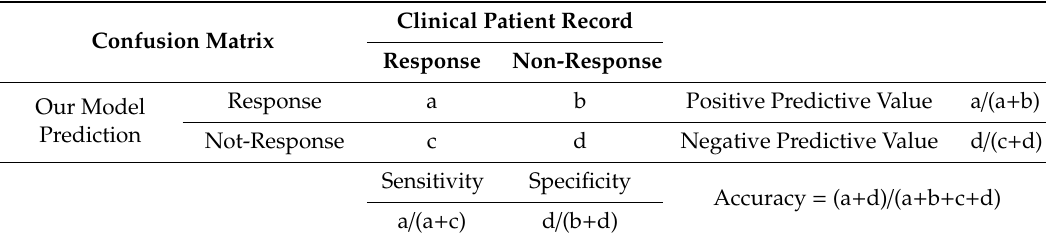
Table 2. Contingency table for drug response comparison between cellular model prediction and true drug response in